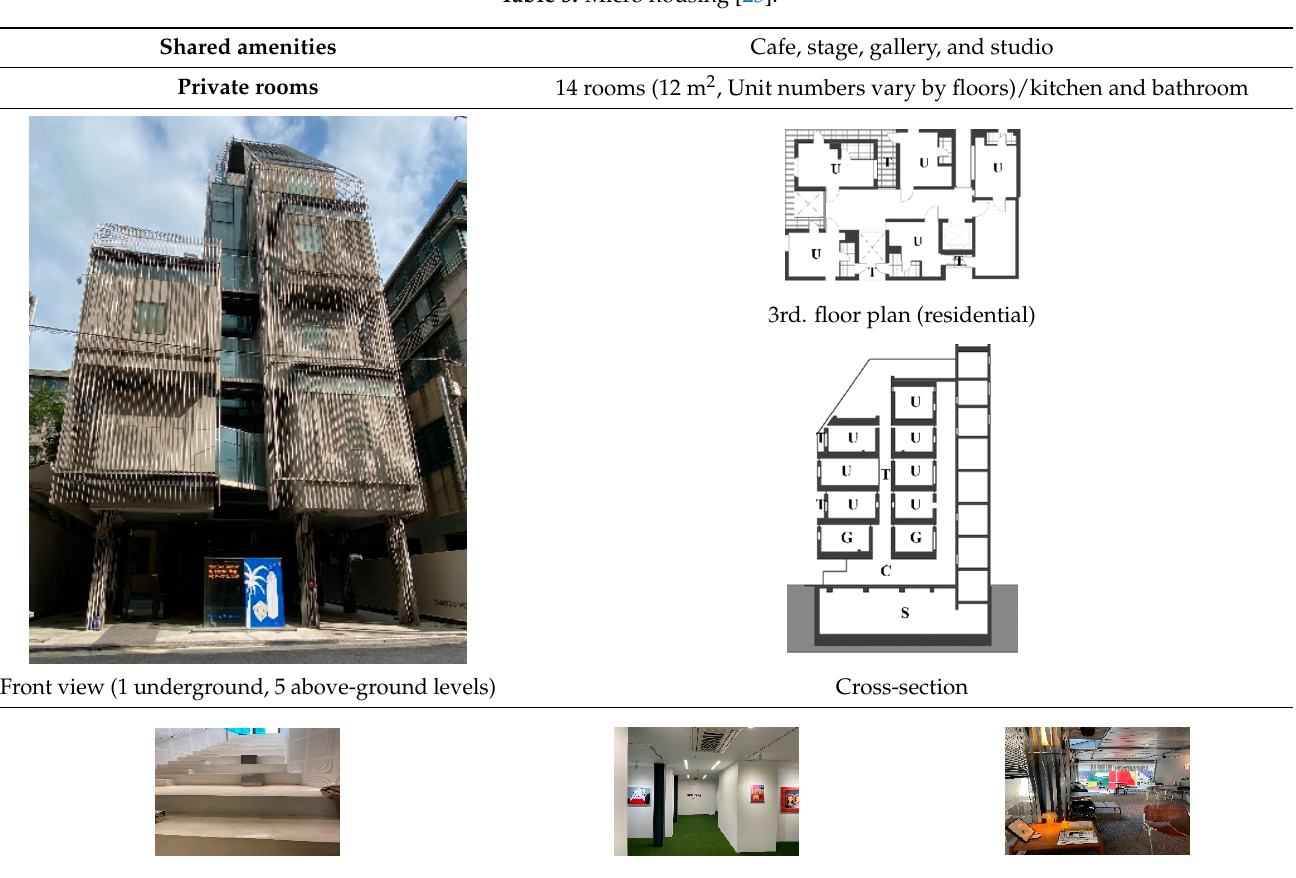
Table 5. Micro housing [23].